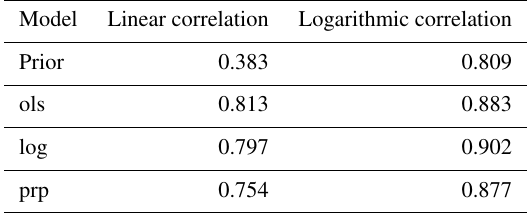
Table 2. Correlation between data and model concentration